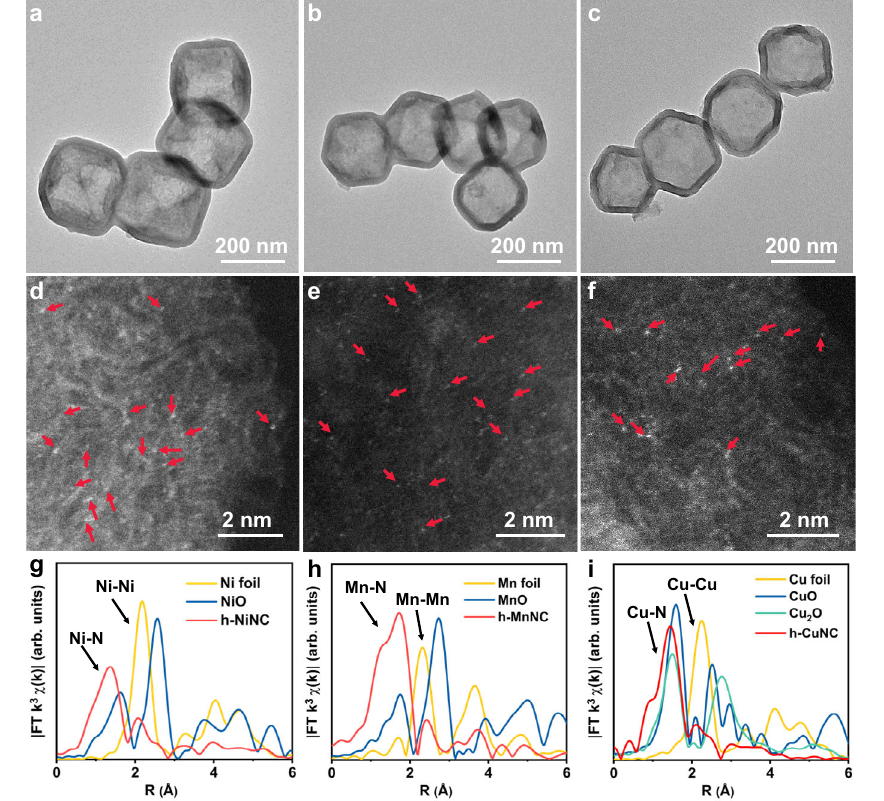
Fig. 3 Characterization of h-MnNC, h-NiNC, and h-CuNC. TEM ( a – c ) and AC-HAADF-STEM ( d – f ) images for h-NiNC ( a , d ), h-MnNC ( b , e ), and h-CuNC ( c , f ), respectively (numerous metal atoms are indicated by red arrows to facilitate identi fi cation). Fourier transform of the EXAFS spectra: g the Ni K-edge of h-NiNC, h the Mn K-edge of h-MnNC, i the Cu K-edge of